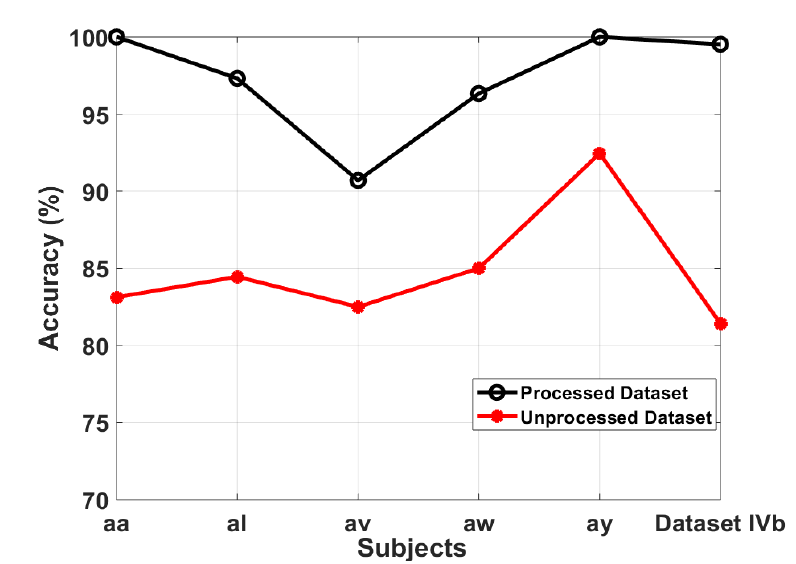
Figure 8. Comparison between denoised and noisy